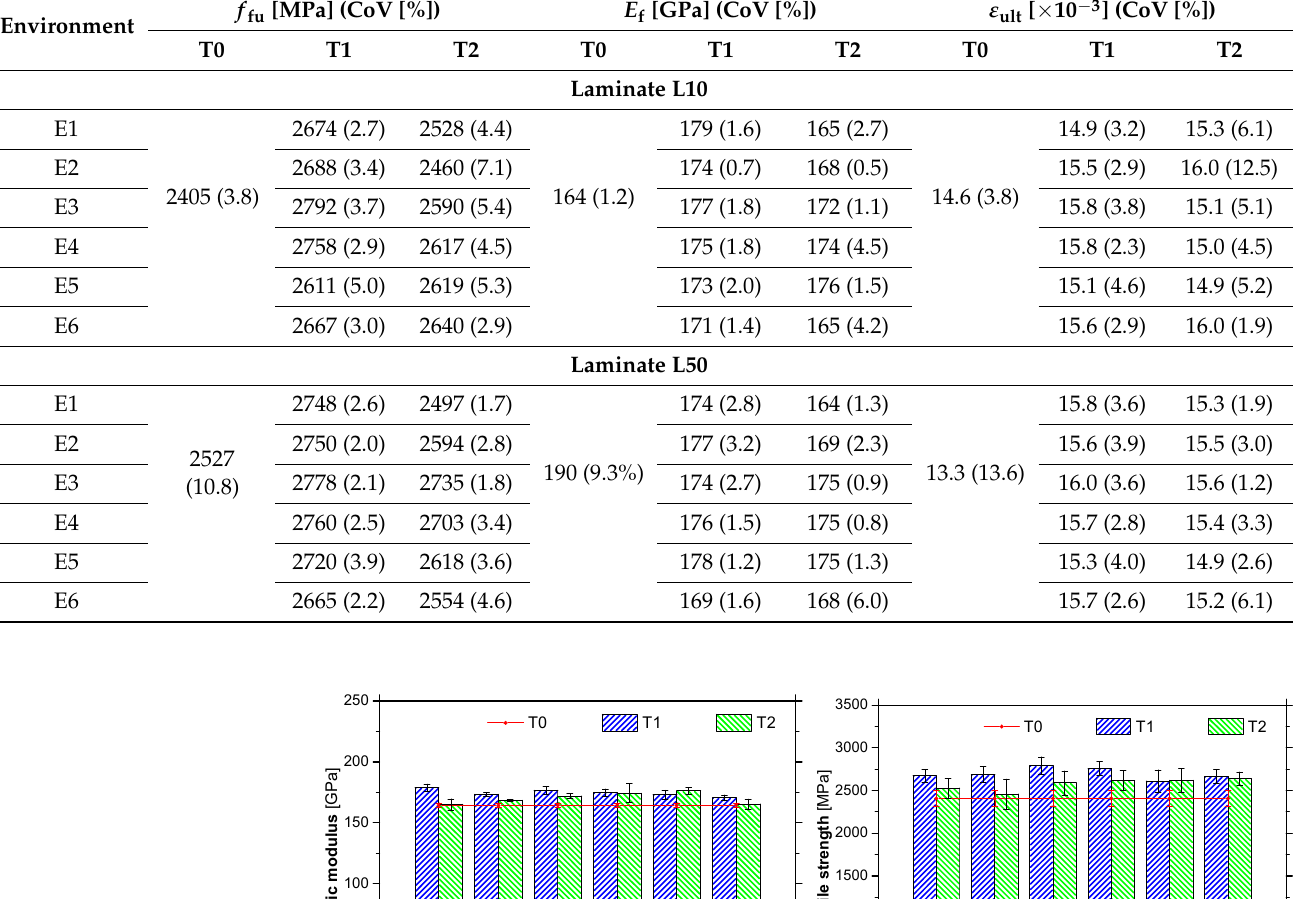
Table 6. Tensile properties of L10 and L50 laminates, after one (T1) and two (T2) years of exposure to the environment studied (E1 to E6), including the reference (T0).